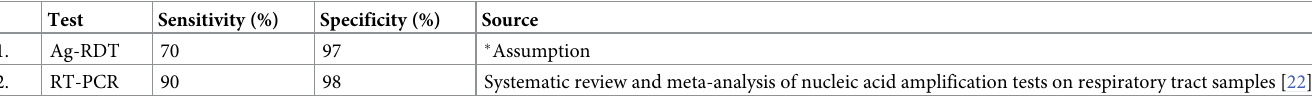
Table 1. Model inputs: Sensitivities and specificities of COVID-19